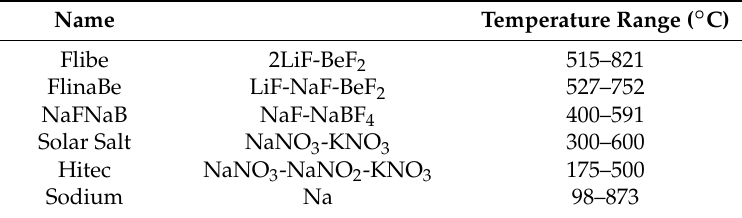
Table 4. Heat transfer fluids (HTFs) considered in this study.